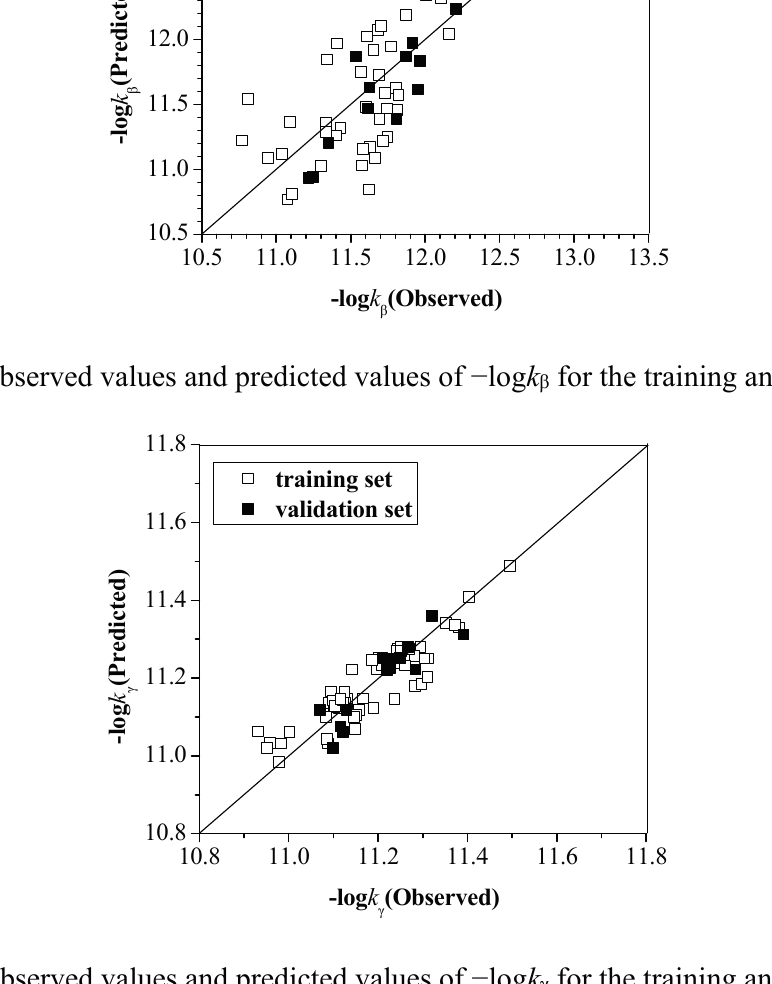
Figure 4. The observed values and predicted values of − log k γ for the training and validation